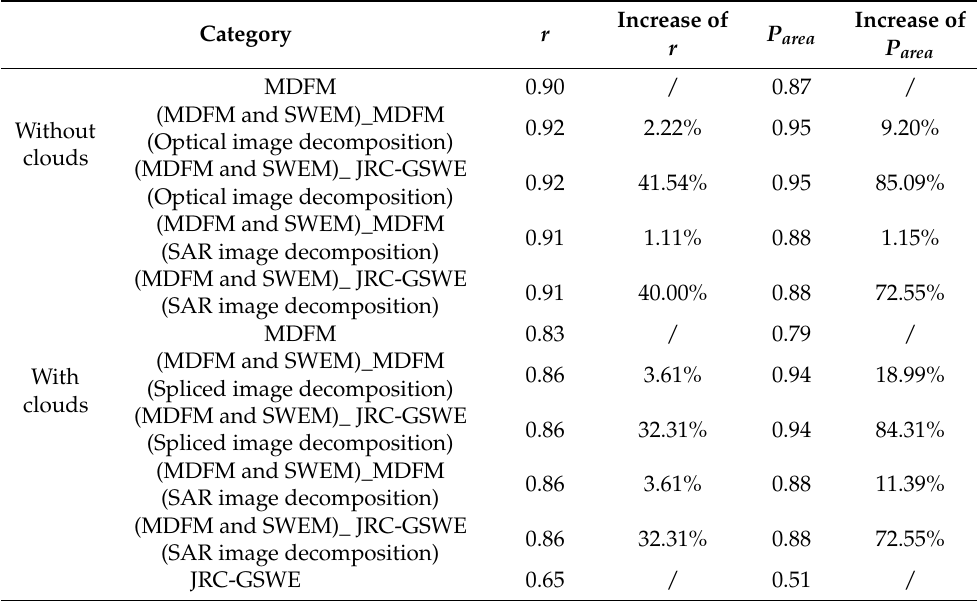
Table 4. Water extraction accuracy in the Yinma River.